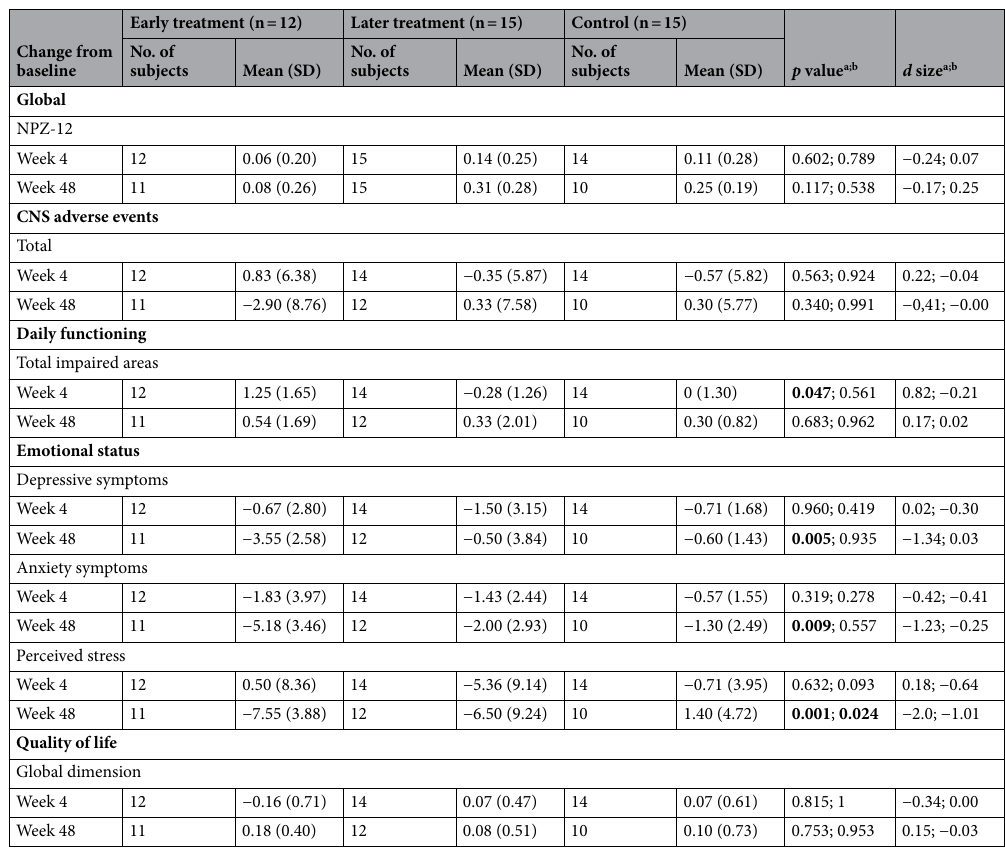
Table 2. Change in cognitive and functional outcomes. Values are expressed as mean (standard deviation). For global neurocognitive performance (NPZ-12) and quality of life, higher change scores represent improvement. For CNS adverse events, daily functioning, emotional status, and stress, lower change scores represent improvement. The treatment and control arms were compared using the independent t test. Statistical significance was set at p < 0.05. Bold values denote statistical significance. d size was obtained using Cohen’s d . Values are considered small when < 0.20, medium when ≥ 0.50 and ≤ 0.80, and large when > 0.80. Abbreviations: CNS = central nervous system. a Comparison between early treatment and control arms. b Comparison between later treatment and control